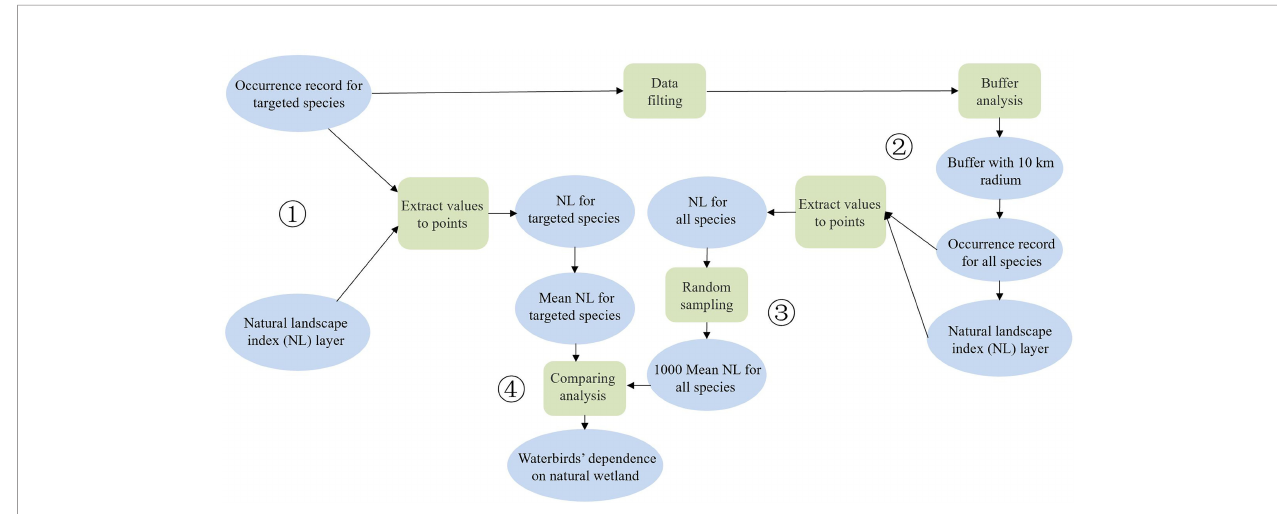
FIGURE 2 | Flowchart demonstrating the calculation method for the bootstrapping